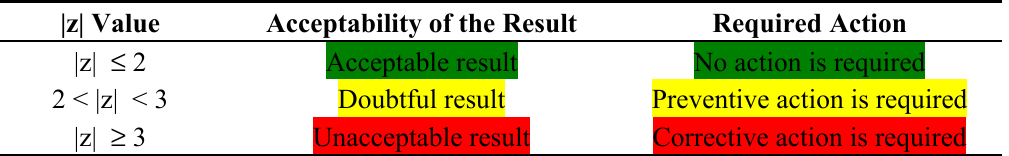
Table 8. Criteria for laboratory performance based on the z -scores assessment.